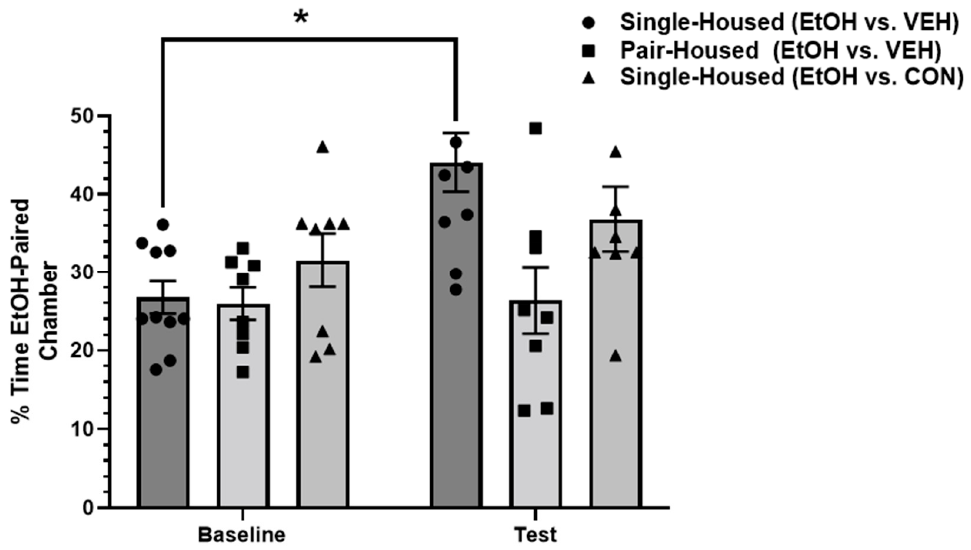
Figure 2. Percentage of time spent in the ethanol-paired chamber at the baseline and test. Single- housed animals that received ethanol or vehicle conditioning (EtOH vs. VEH) demonstrated an increased amount of time spent in the ethanol-paired context at test. Pair-housed animals that received ethanol or vehicle conditioning showed no increase in time spent in the ethanol-paired context at test. Single-housed animals that received ethanol or concurrent socially-paired context conditioning also showed no ethanol place preference. EtOH = ethanol-paired context; VEH = vehicle-paired context; CON = conspecific-paired context * Denotes significant difference at p < 0.05.